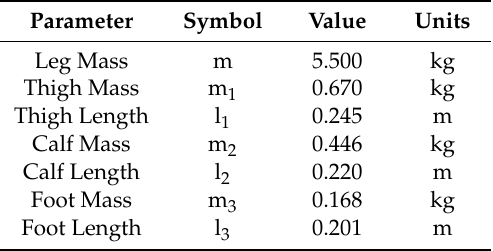
Figure 6. Structural design of one leg of the quadruped. Table 1. Physical leg parameters.